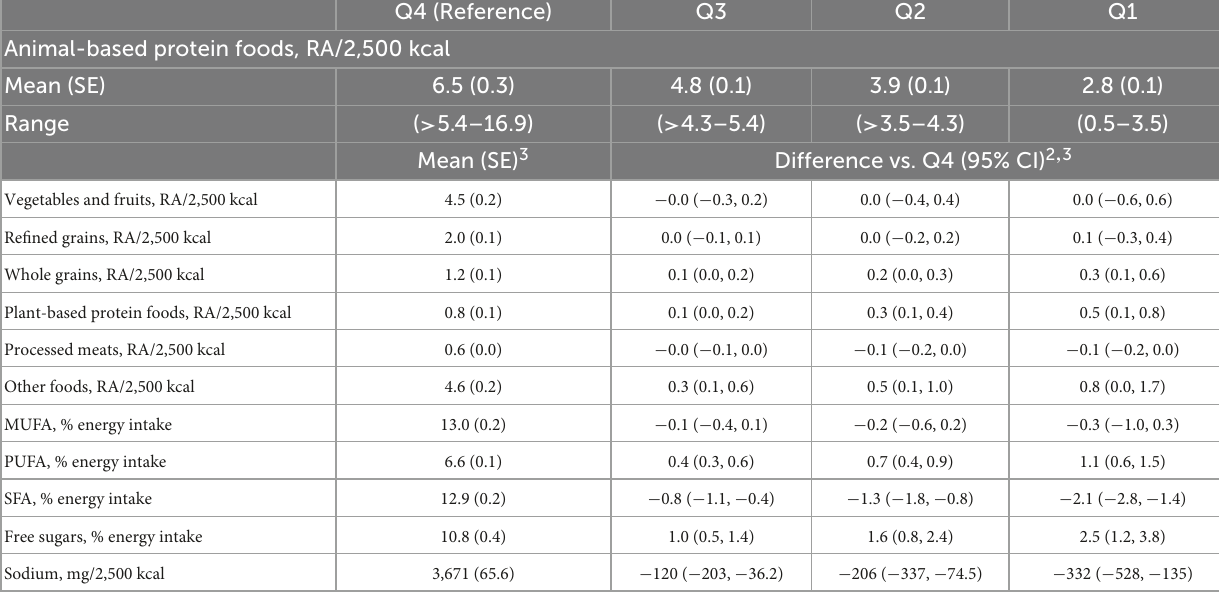
TABLE 4 Usual food and nutrient intakes across quarters of animal-based protein food intake in French-speaking adults from Québec, Canada 1 , 4 . Q4 (Reference)